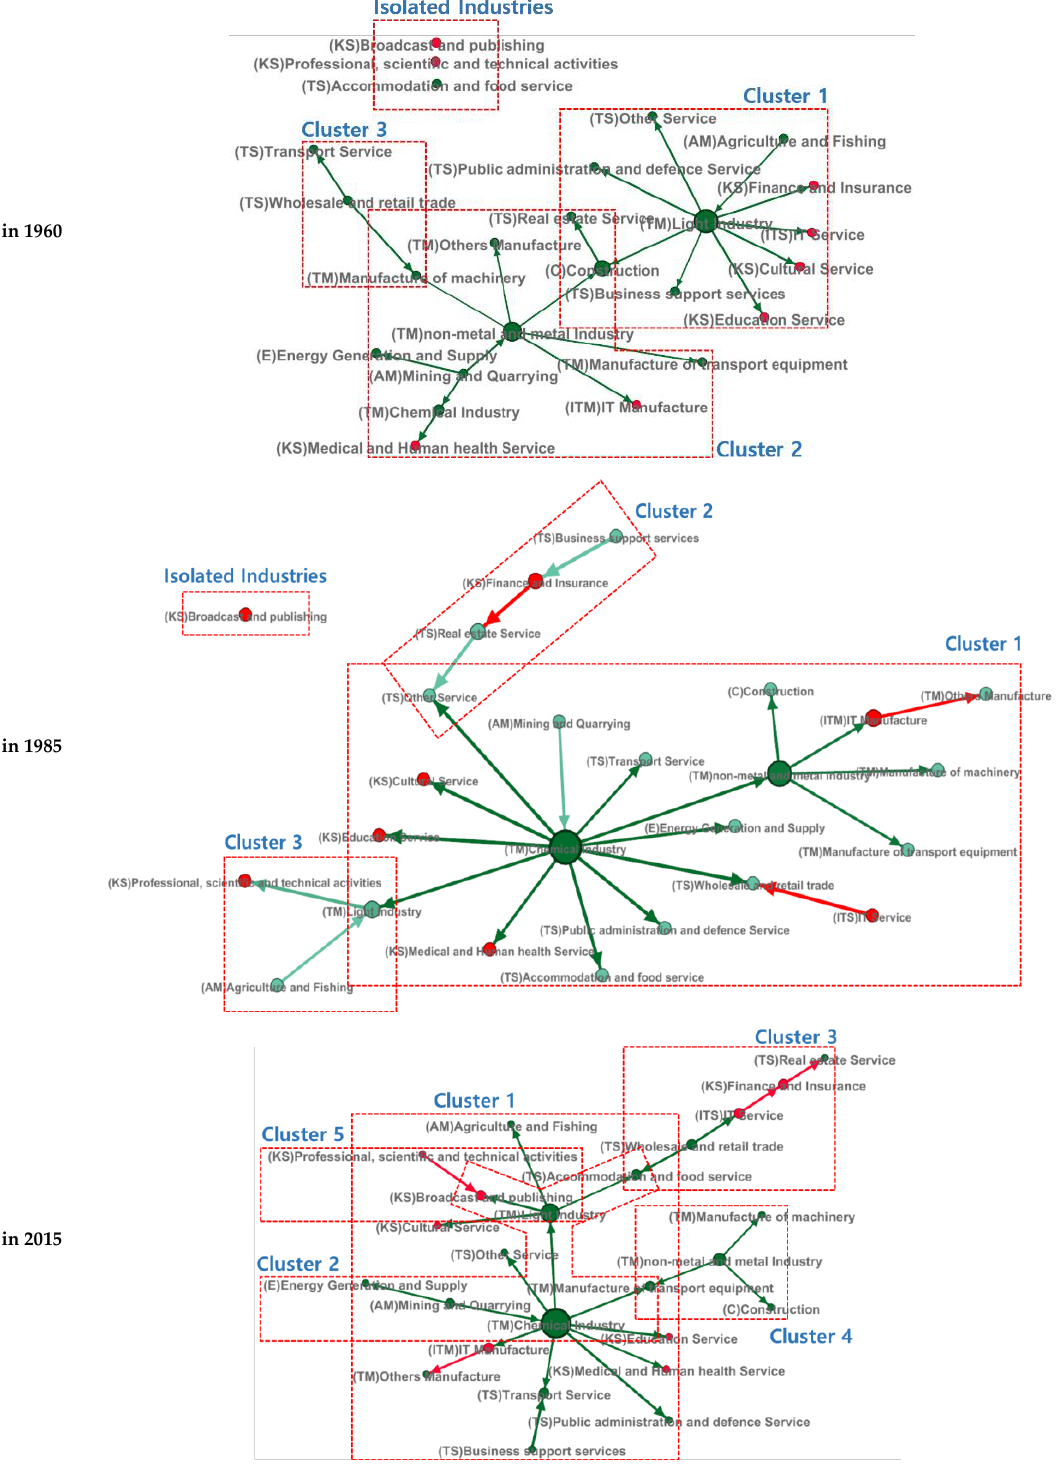
Figure A1. Changes in Smart Network Clustering. (Note: The red nodes are smart industries. The green nodes are traditional industries.)